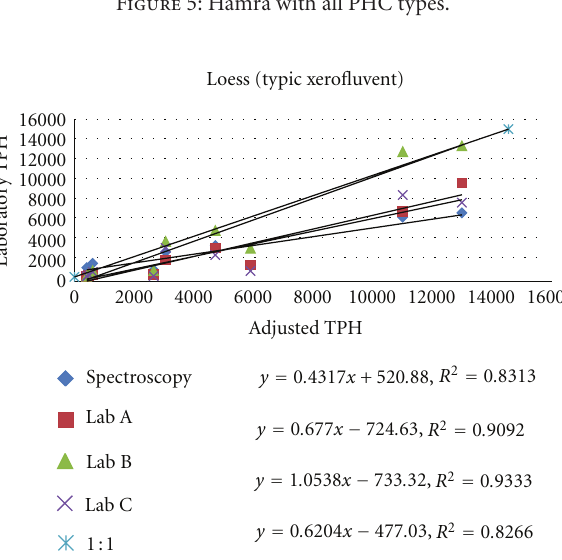
Figure 5: Hamra with all PHC types.